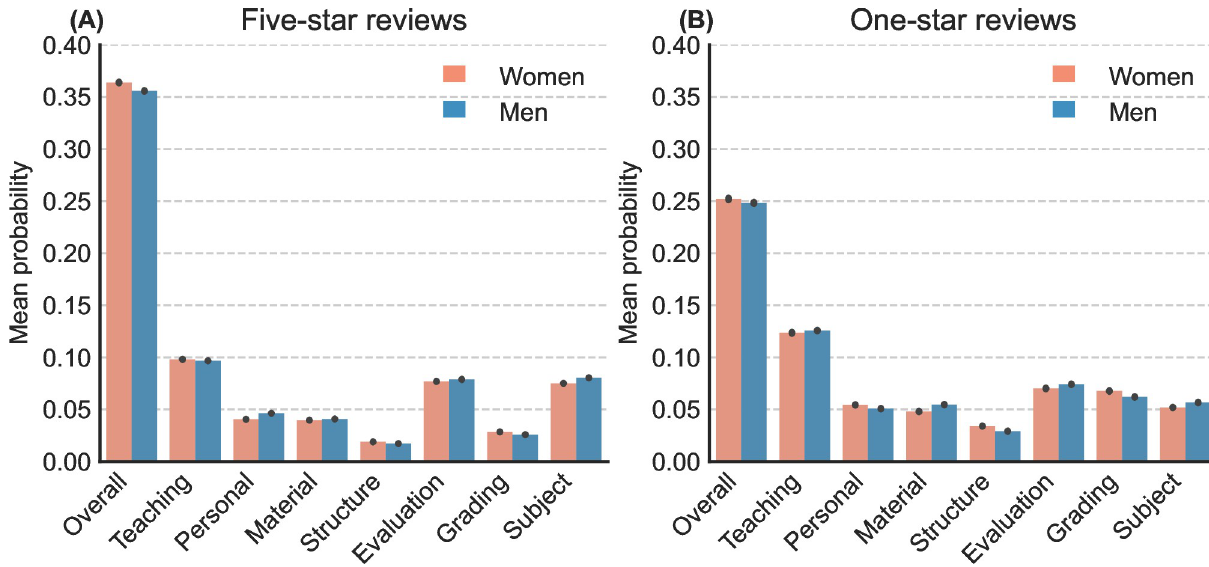
Fig 2. Mean possibilities of comment sentences pertaining to topic dimensions by genders. (A) In five-star reviews. (B) In one-star reviews.